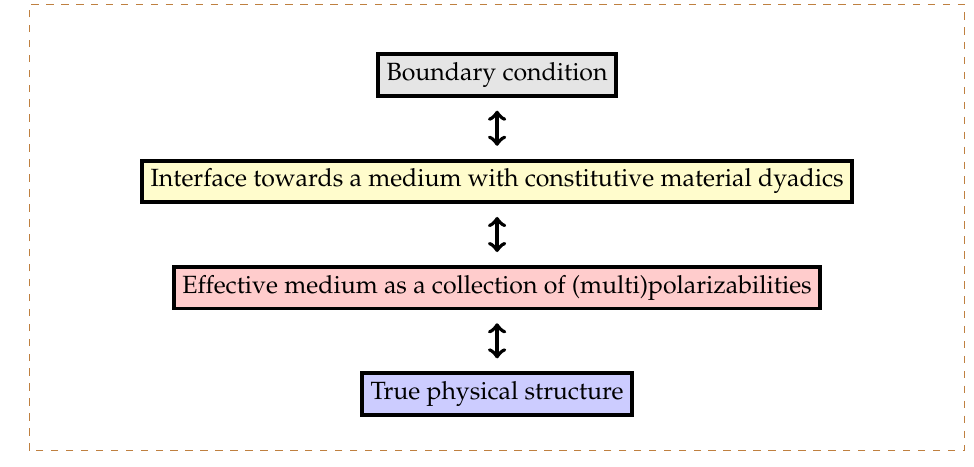
Figure 7. Levels of materialization of a given boundary: the medium whose surface imitates the boundary condition is described by a set of electromagnetic constitutive material parameters. On the other hand, the ultimate physical material itself can be modeled as a collection of polarizable particles whose electric and magnetic dipole moments effectively homogenize into these constitutive